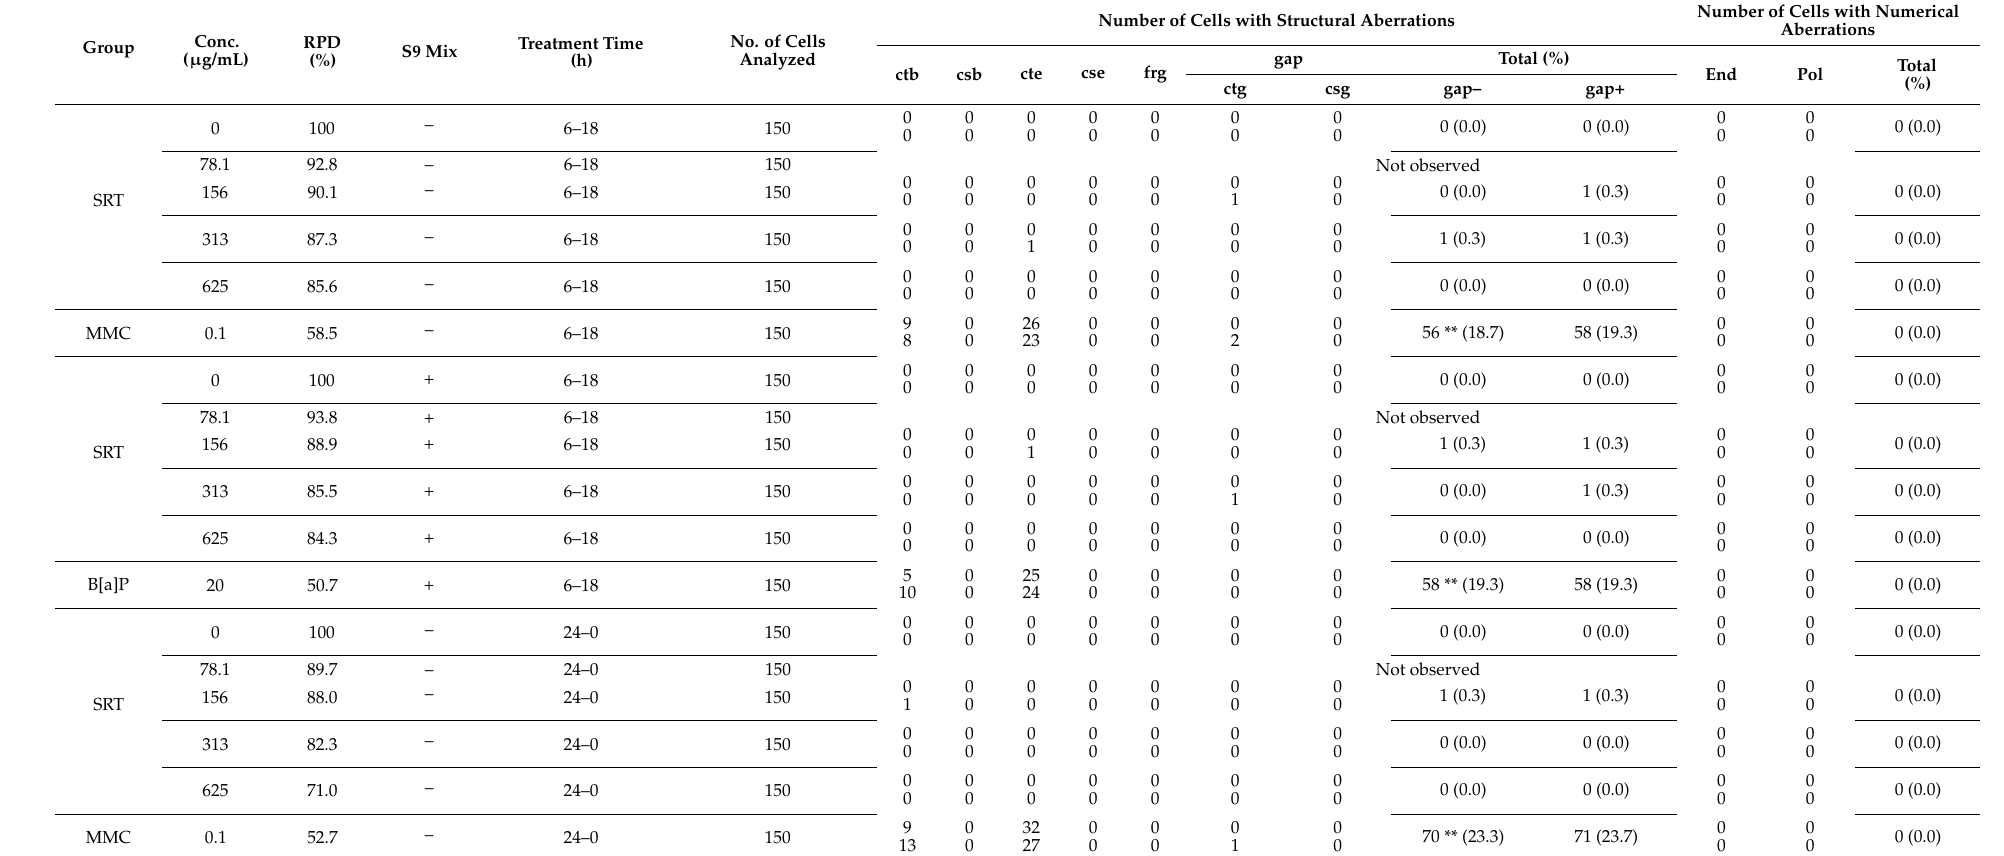
Table 1. Chromosomal aberrations due to SRT in Chinese hamster lung